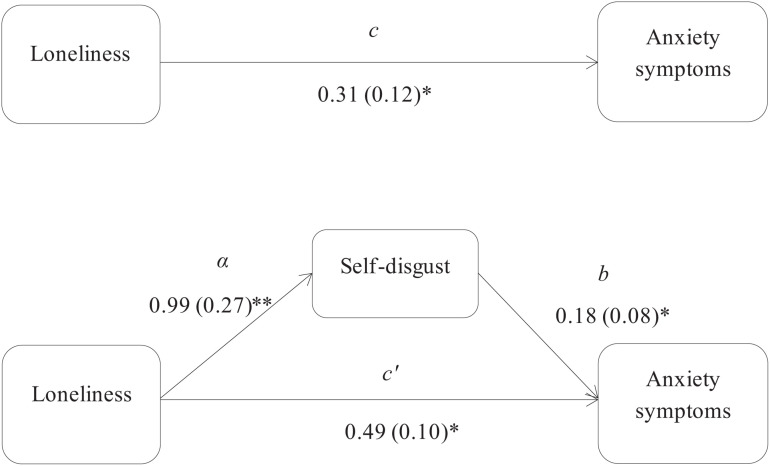
Self-disgust mediates the association between loneliness and anxiety symptoms in the PTSD group. Note: The total (c) and the indirect effect (c’) of loneliness on anxiety symptoms are shown; Unstandardized path coefficients are presented, with standard errors in brackets. ∗p ≤ 0.05; ∗∗p ≤ 0.005.